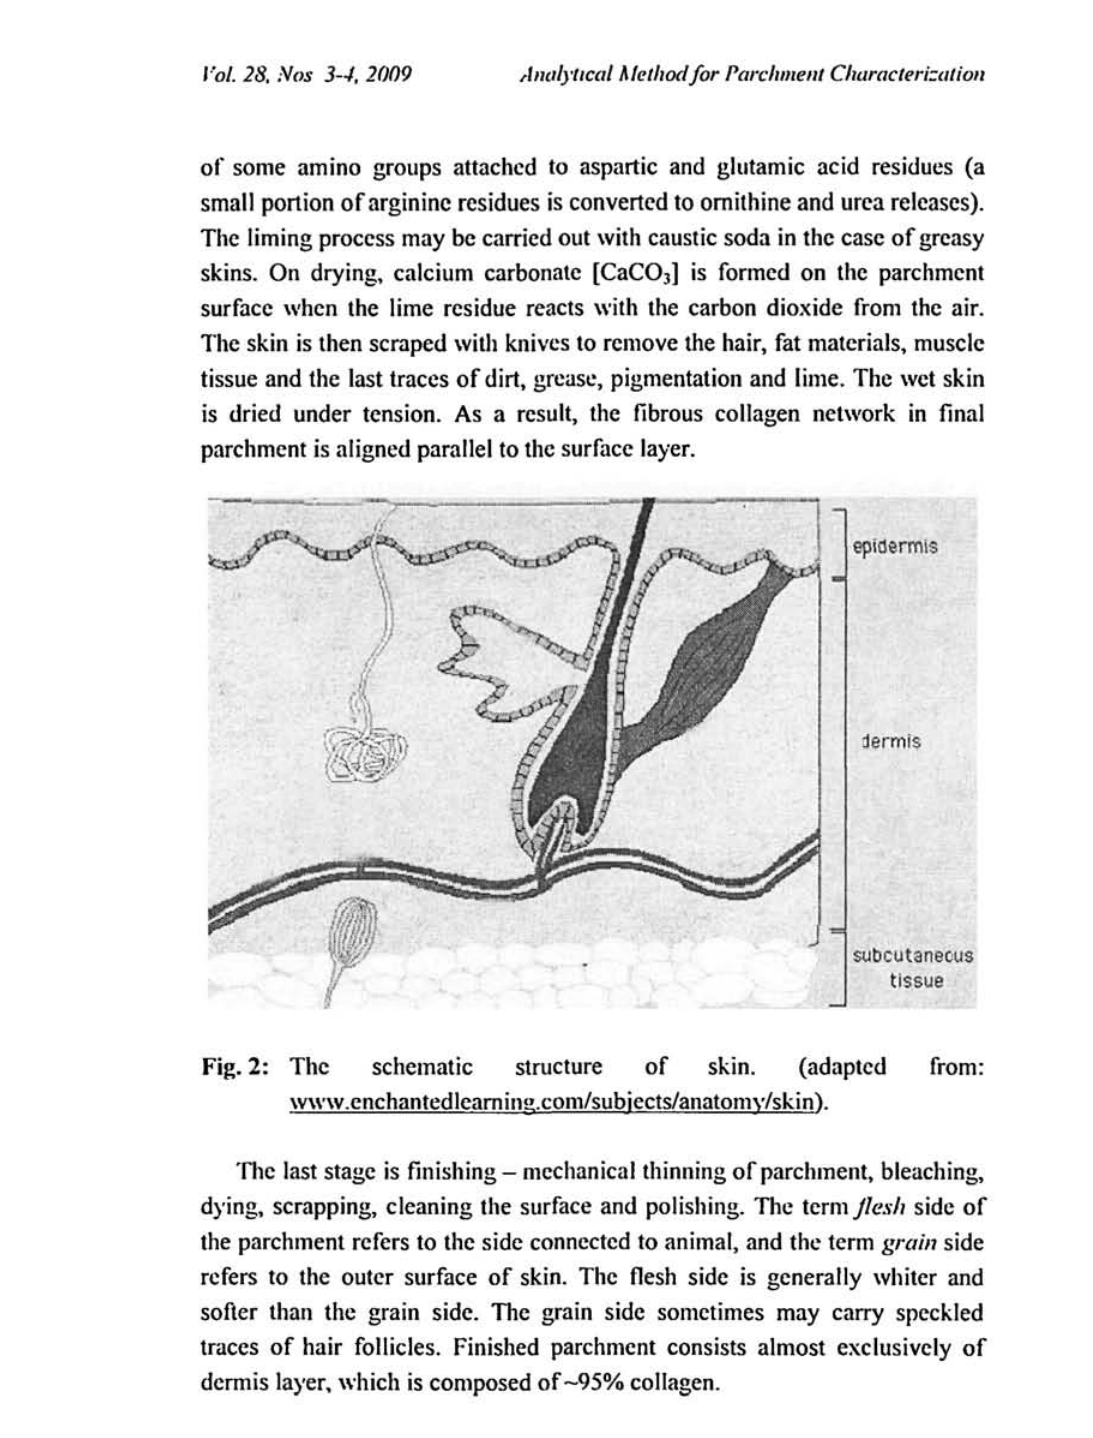
Fig. 2: The schematic structure of skin. (adapted from: